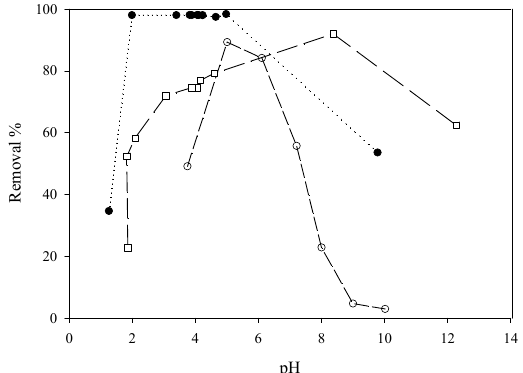
Figure 20. % removal of As through adsorption by iron(III)-loaded SOJR gel and through the conventional coprecipitation method using ferric chloride plotted against equilibrium pH values. ● : Adsorptive removal of As(V) by Fe(III)-loaded SOJR gel. □ : adsorptive removal of As(III) by Fe(III)-loaded SOJR gel, ○ : removal of As(V) through coprecipitation using ferric chloride [15]. (With permission for reuse from The Mining and Materials Processing Institute of Japan).